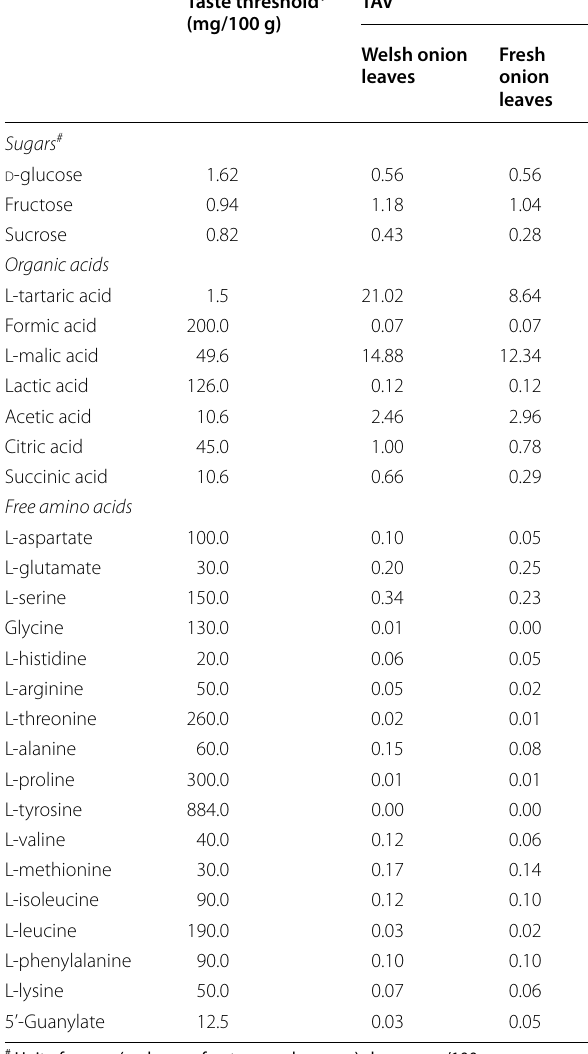
Table 2 Taste-active value (TAV) of taste components in leaves of Welsh onion and fresh